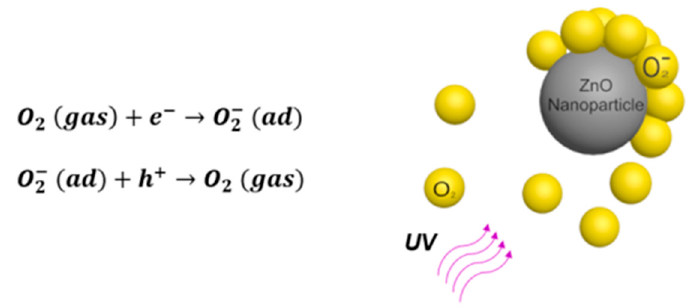
Figure 1. Oxygen adsorption and desorption on ZnO NP.